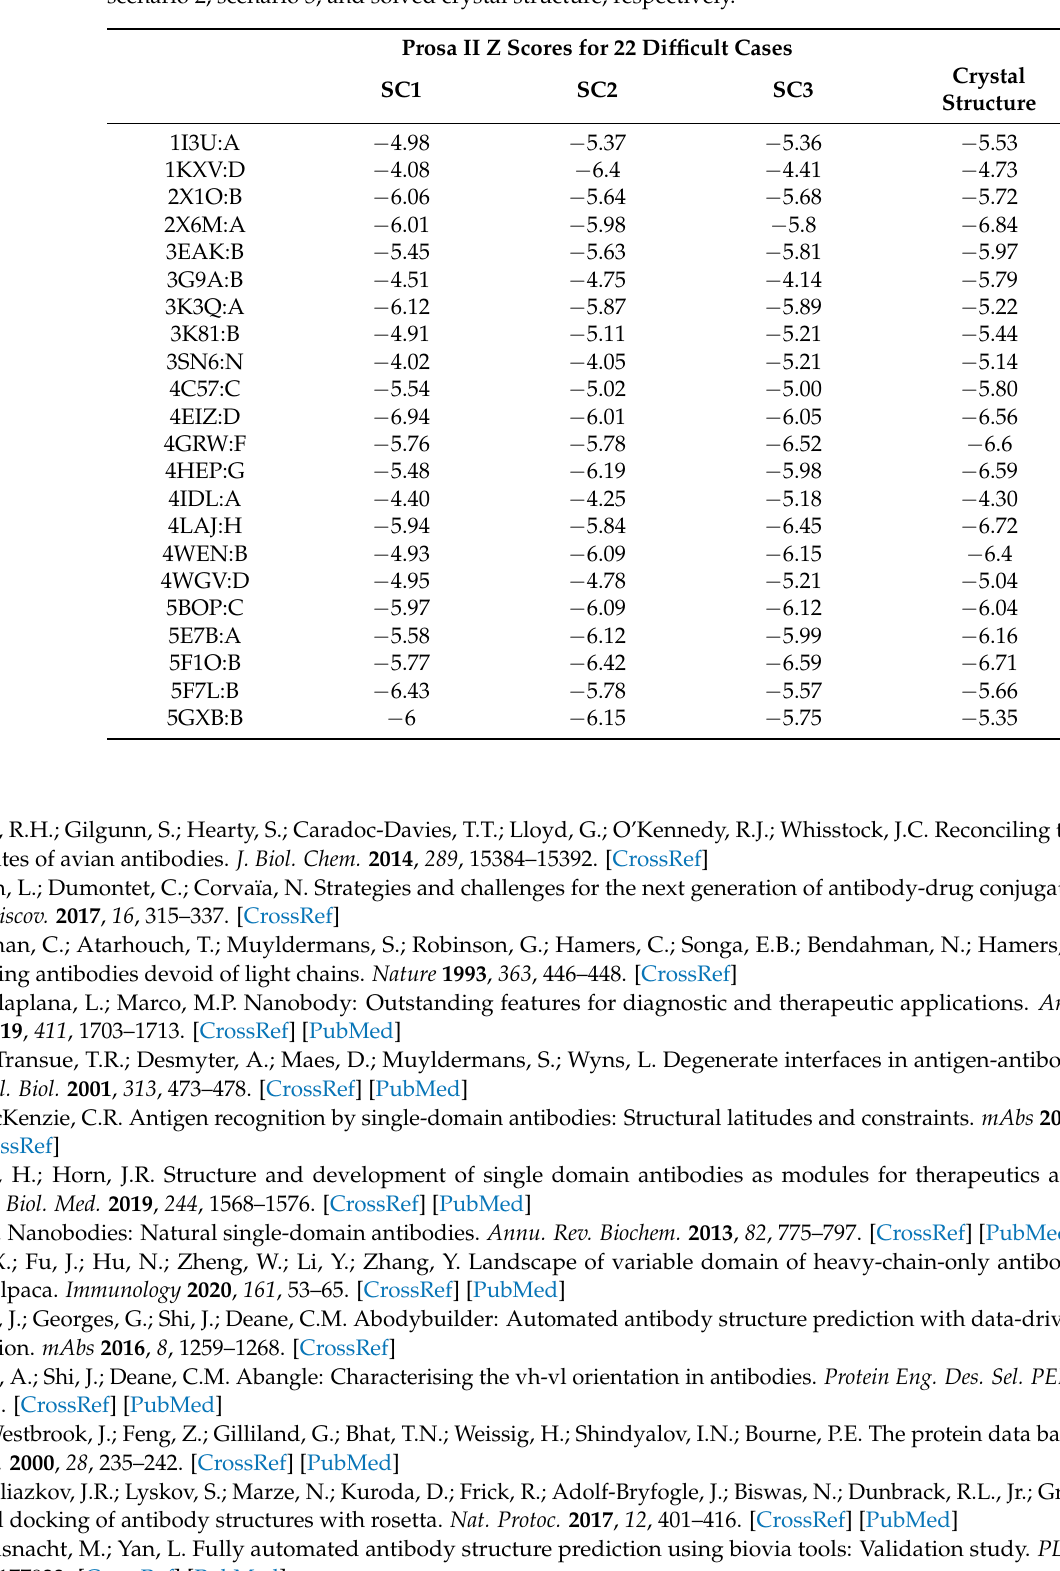
Table A1. Prosa II Z -Score values for the best DOPE models selected. Column 1: sequence from the PDBID:chainID used. Column 2, 3, 4, and 5: Z-score value of the selected model from scenario 1, scenario 2, scenario 3, and solved crystal structure,